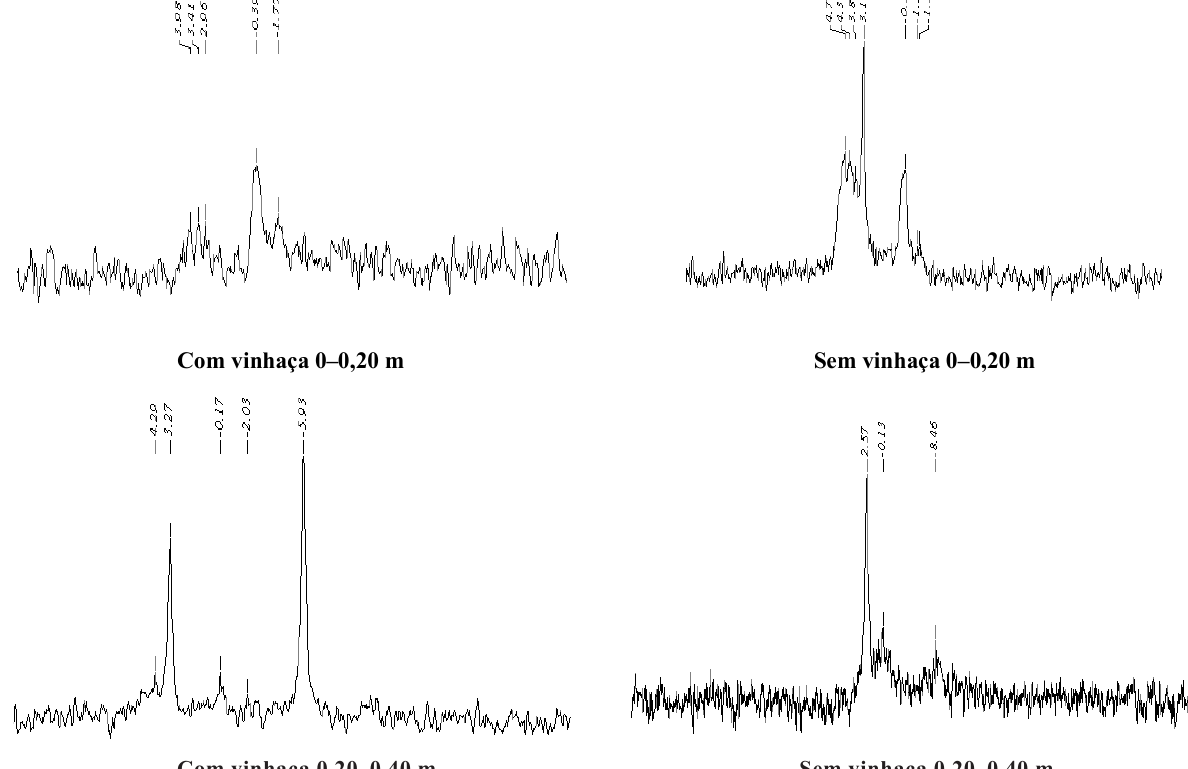
Figura 2. Espectros de RMN 31 P de ácidos húmicos extraídos de um Cambissolo Háplico Ta eutrófico vértico submetido aos manejos com ou sem aplicação de vinhaça na cultura da